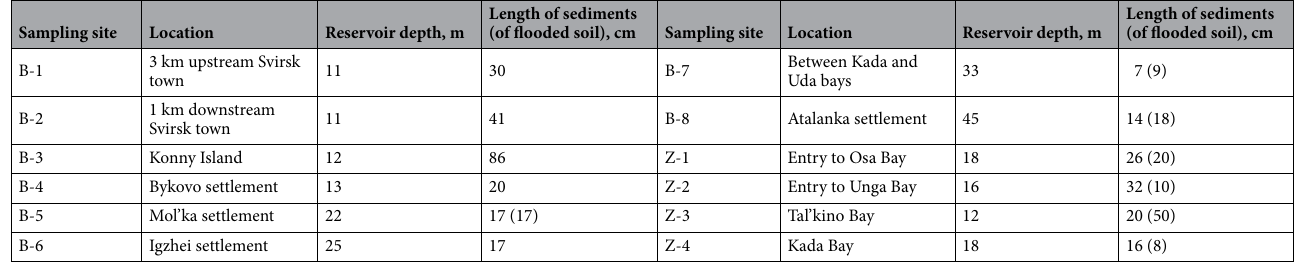
Table 1. Characterization of sediments and pore water sampling